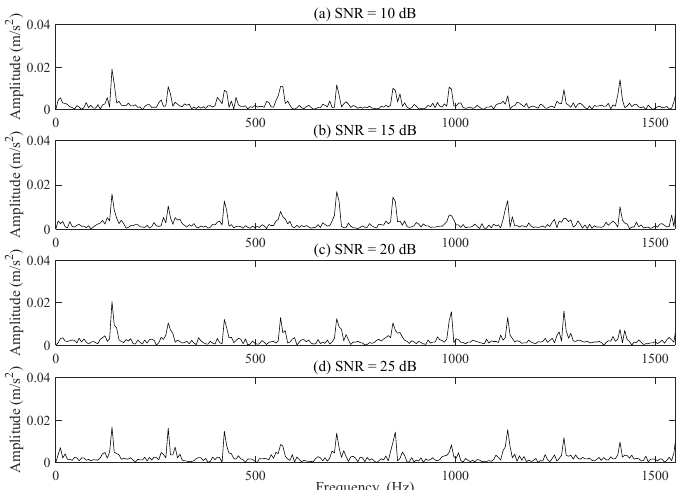
Figure 25. The time ‐ domain and frequency ‐ domain waveforms of four rolling element signals with different noise levels.